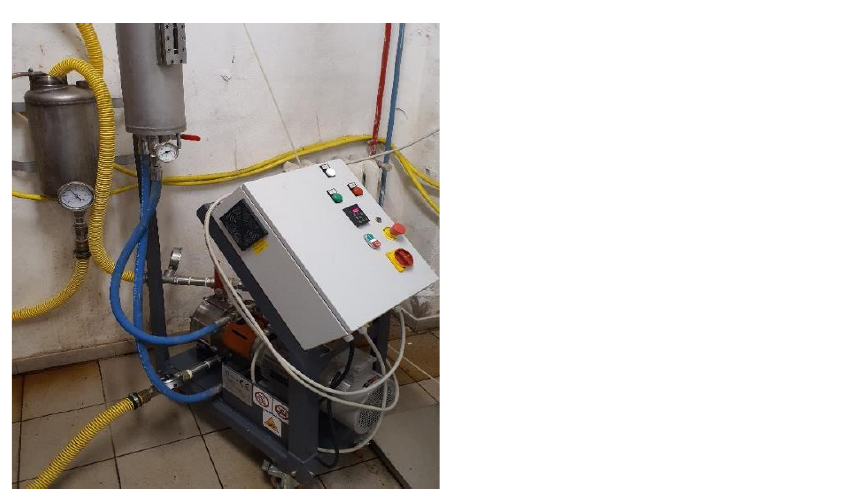
Figure 2. Rotor/stator HC reactor (EPIC Srl) at DSTF — University of Turin.